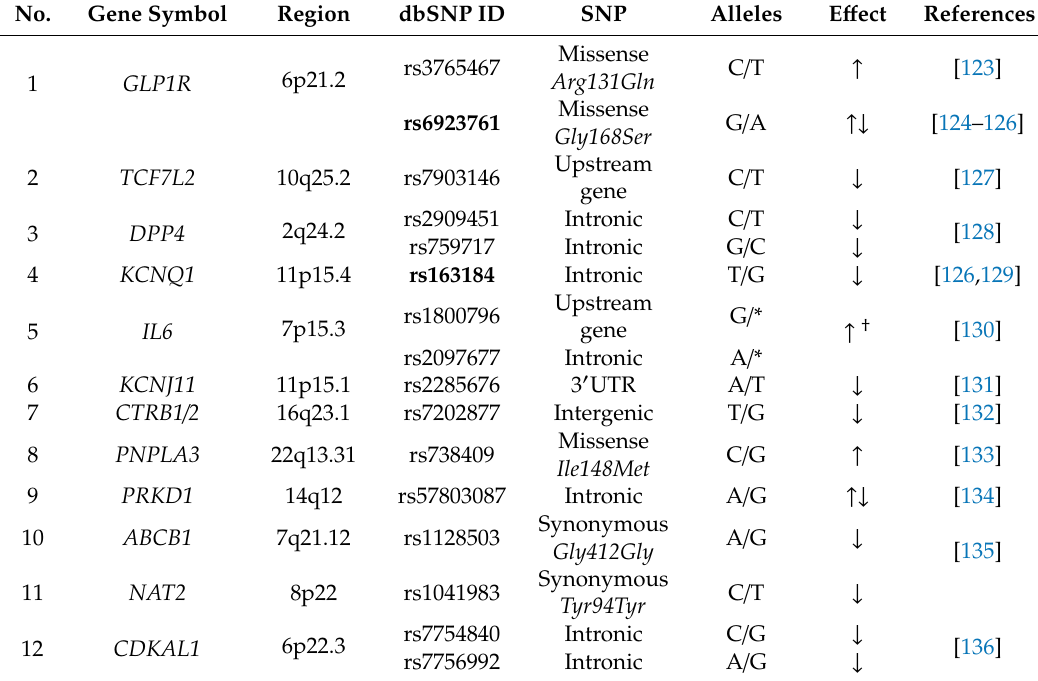
Table 4. Genetic variants that influence DPP4I therapy